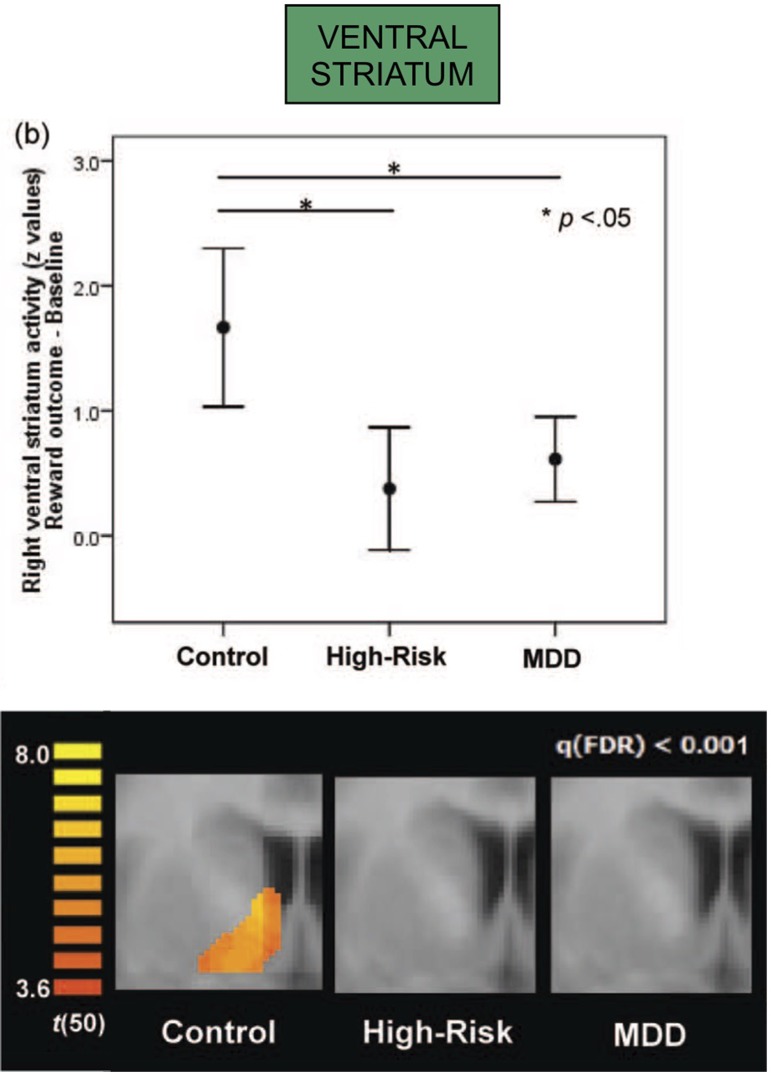
Both major depressive disorder (MDD) and high-risk groups (with current depression in mother but not in adolescent) show attenuated right ventral striatum activation in response to a standard reward outcome during functional MRI scanning (both *p < .05; error bars depict 95% confidence interval); activation for the reward outcome versus baseline contrast within the ventral striatum region of interest, presented at false-discovery-rate-corrected q < .001; the activations are shown at y = 5. Adapted from (117). Used with permission.